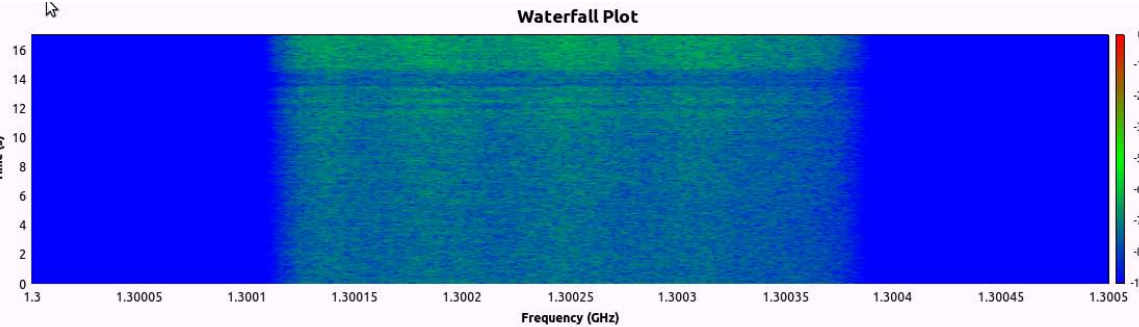
Figure 8. Sensing results according time at 1.30025GHz.